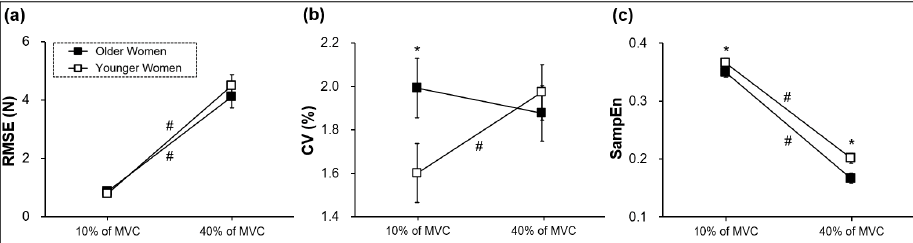
Figure 3. Bimanual force control performances (M ± SE). ( a ) Force accuracy showing a significant Force Level main effect. ( b ) Force variability showing a significant Group × Force Level interaction. ( c ) Force regularity showing significant Group and Force Level main effects. Asterisk (*) indicates a significant difference between two groups. Number sign (#) denotes a significant difference between 10% and 40% of MVC.